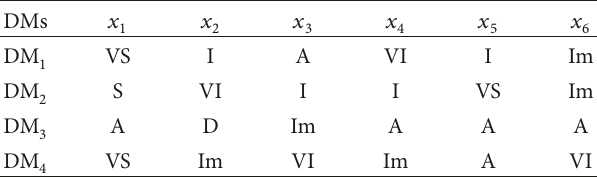
Table 12: Comparison of rank for each alternative. Table 13: Defuzzy values of 𝐵𝑁𝑥 and 𝐶𝑥 𝑗 .